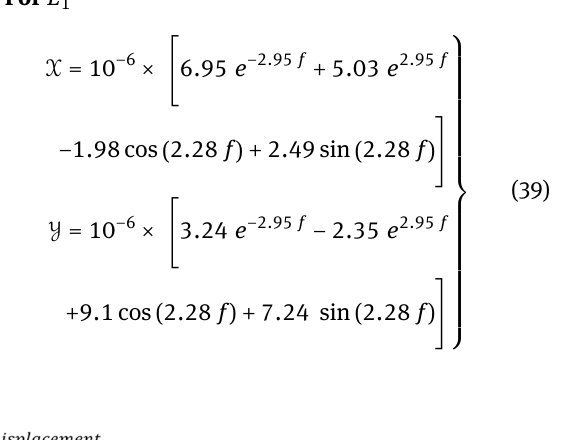
Figure 1. Location of vs. for two different cases, CRTBP for spherical primaries and ERTBP with oblate and triaxial primaries.